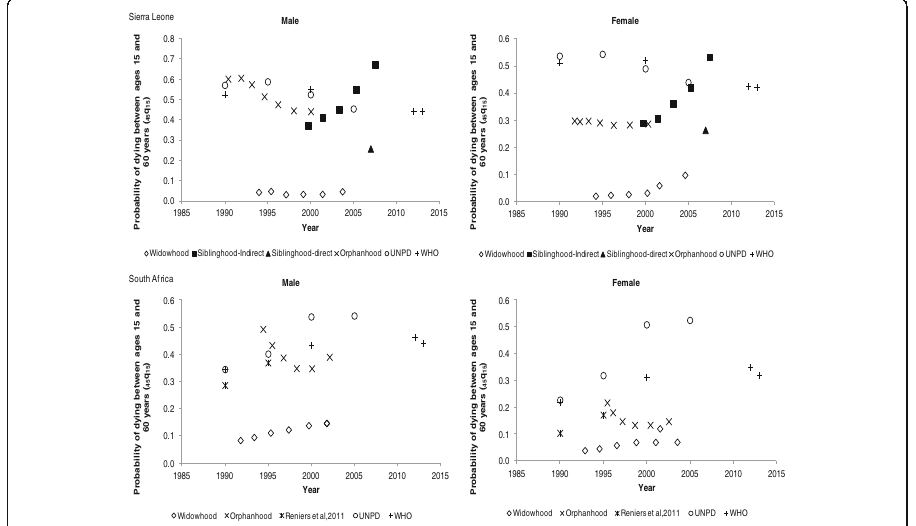
Fig. 3 Probability of dying between ages 15 and 60 years ( 45 q 15 ) by sex in Sierra Leone and South